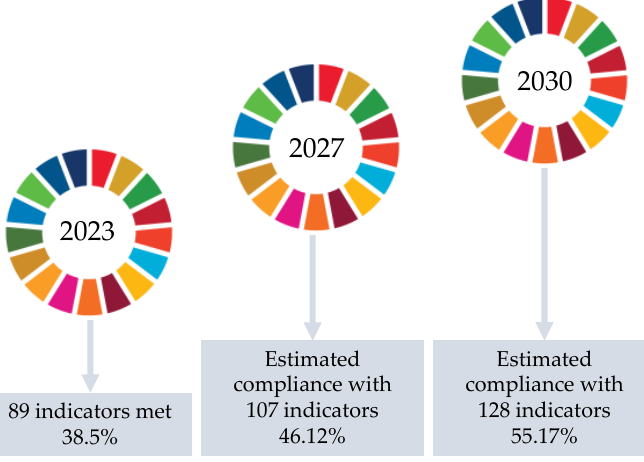
Figure 7. Sustainability roadmap on the ACTIVA